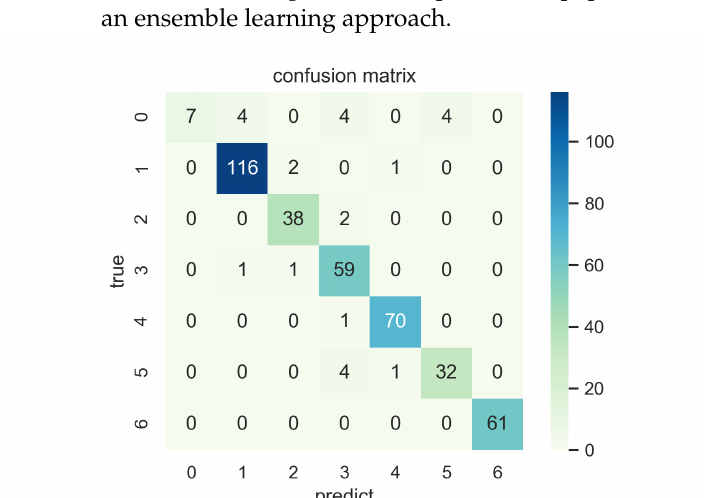
Figure 10. The confusion